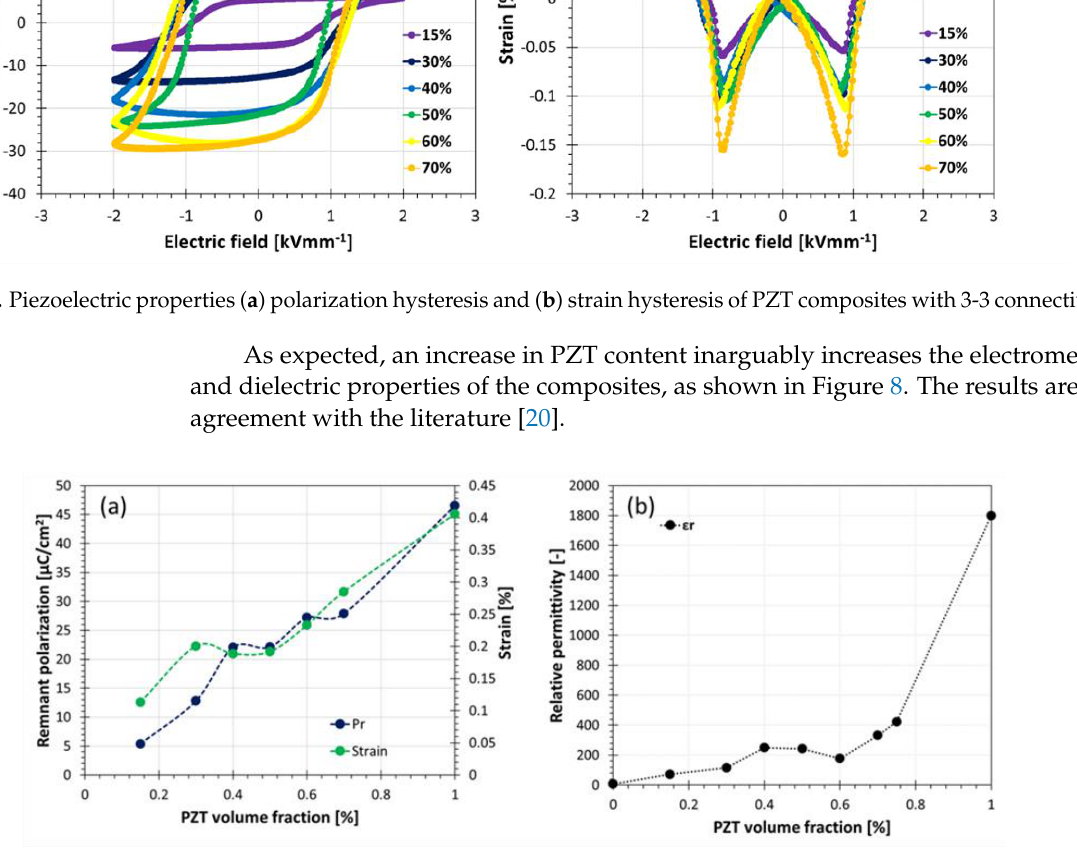
for PZT epoxy piezoelectric composites with 3-3 connectivity as a function of PZT volume content.